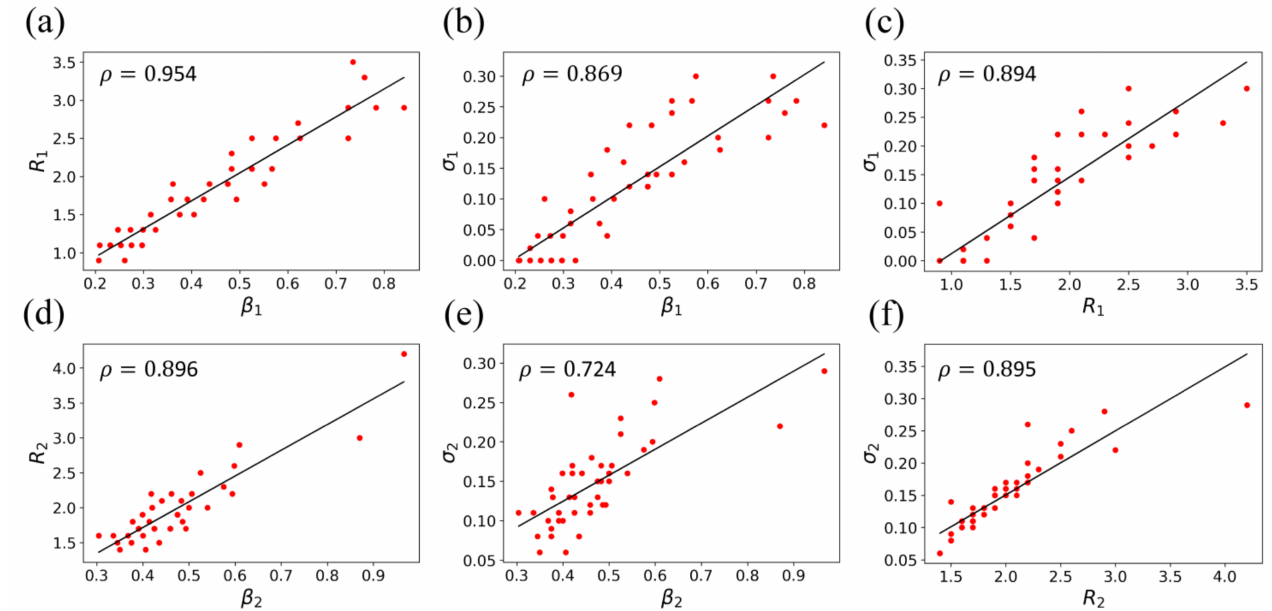
Figure 4. The pairwise relationships and their correlation coefficients of three epidemic parameters, R , β , and σ , of the T-SIR model for the first outbreak ( a – c ) and second outbreak ( d – f ), where the solid lines are the linear fittings of the